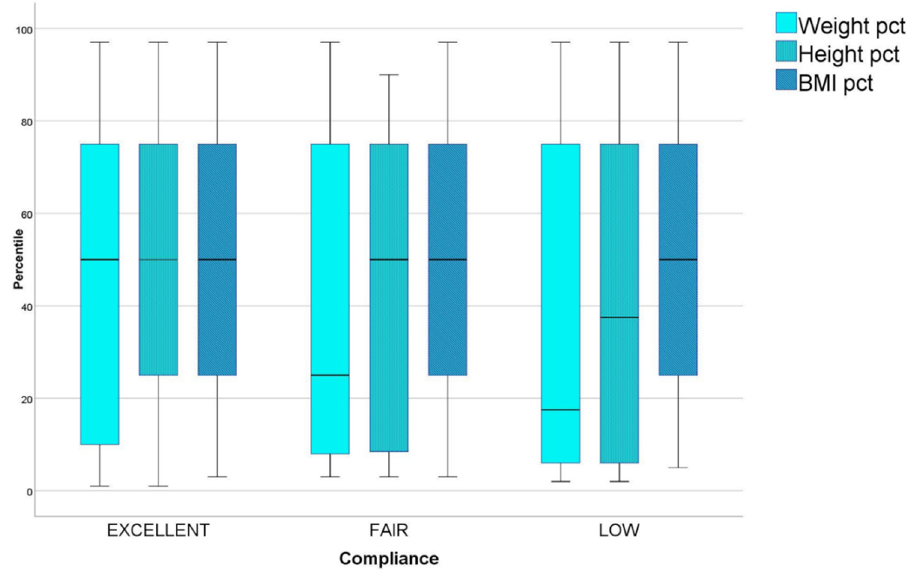
Figure 1. Average weight, height and BMI percentiles in patients with excellent, fair and low adherence to GFD.